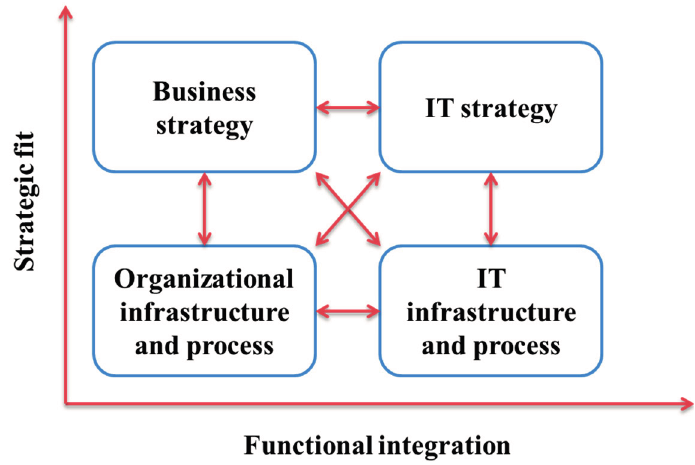
Figure 2. The “strategic fit” and “functional